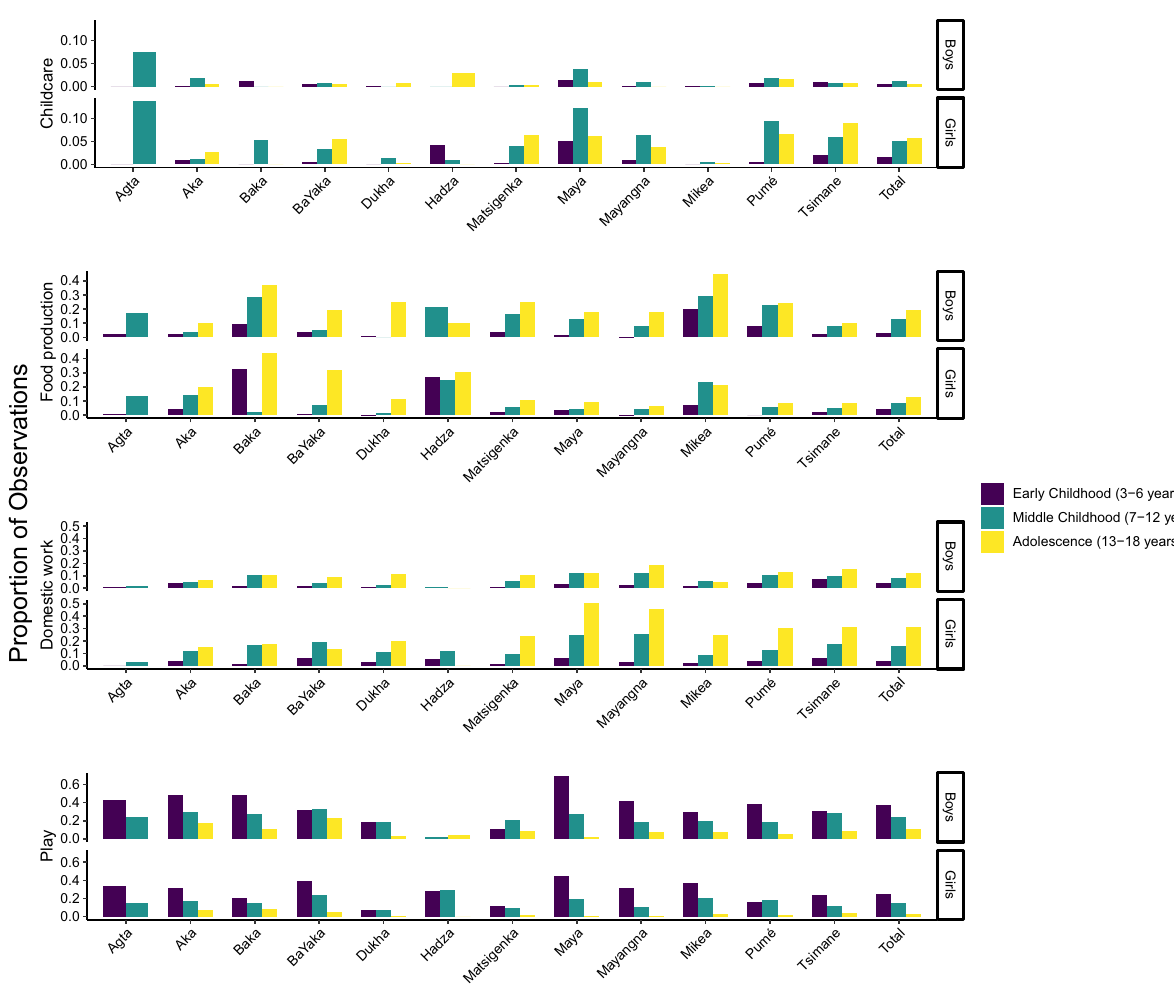
Figure 2. Time allocation by study population, gender, and age. Values represent mean individual proportion of total observed